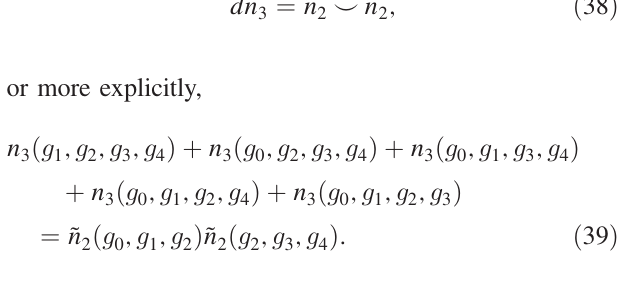
¯0 ¯2 ¯1 to and to ˜ P indicate that